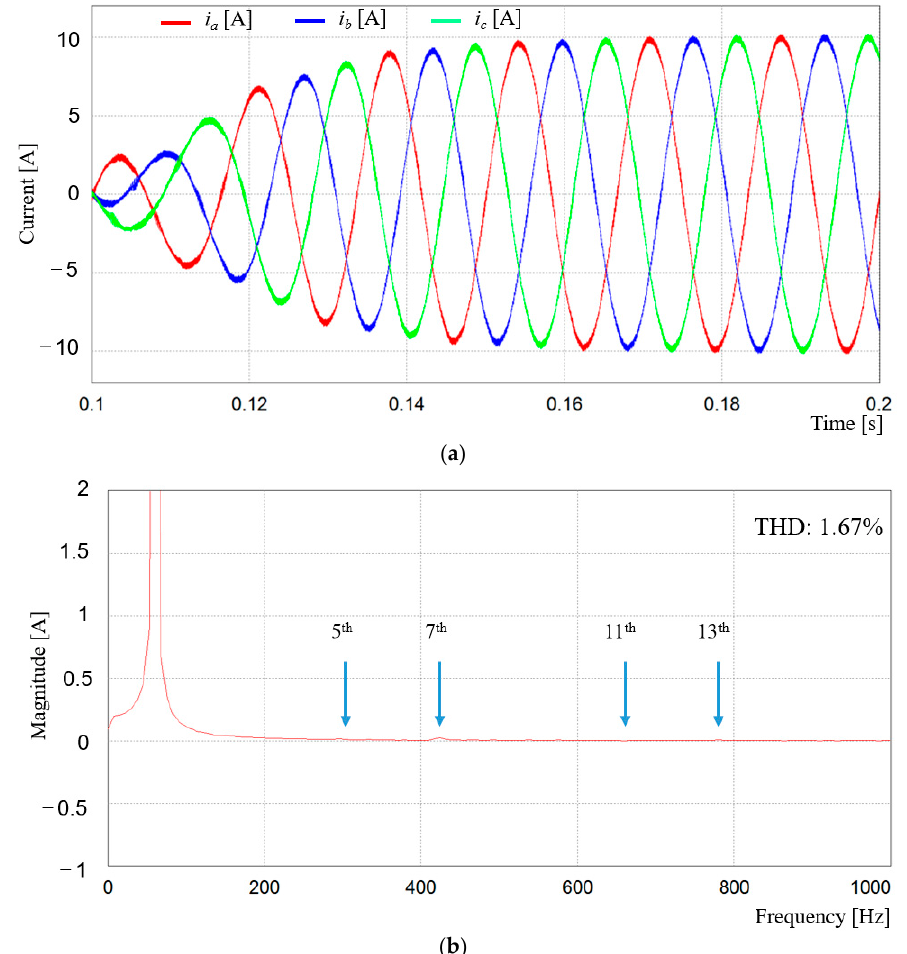
Figure 7. Inverter currents of the FCS-MPC scheme with the BPF under distorted grid voltages. ( a ) Phase currents; ( b ) FFT result of a -phase current.